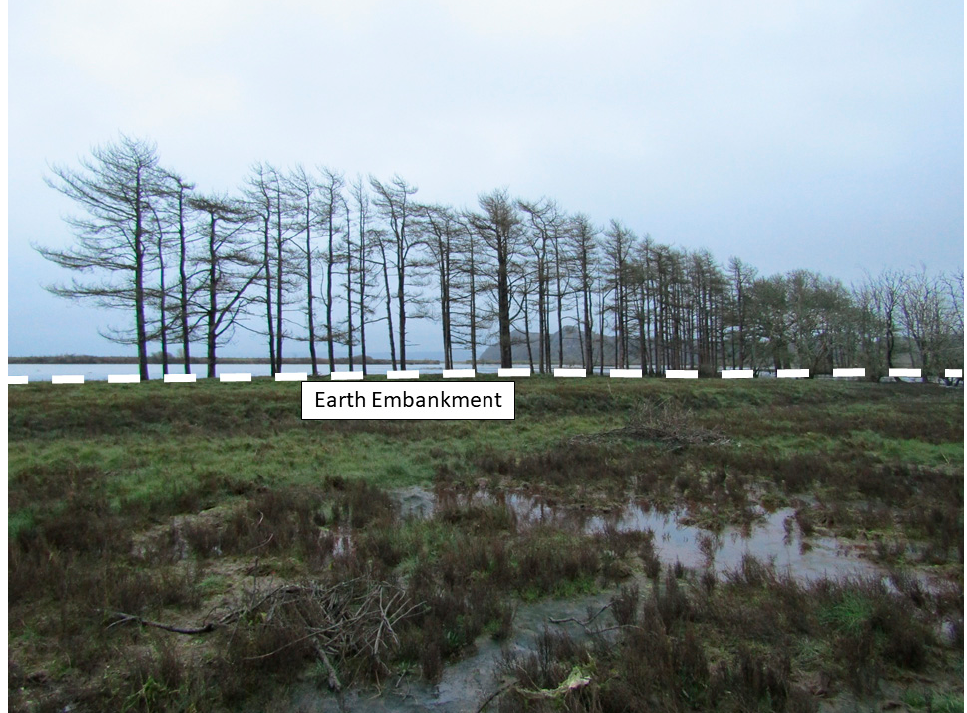
Figure 3. The tree-lined earth embankment which divides Zone 2 from Zone 3, marked by the white dashed line and labelled. The photograph was taken looking south-east towards the breach area across Zone 2 into Zone 3 (photography: H. Burgess).